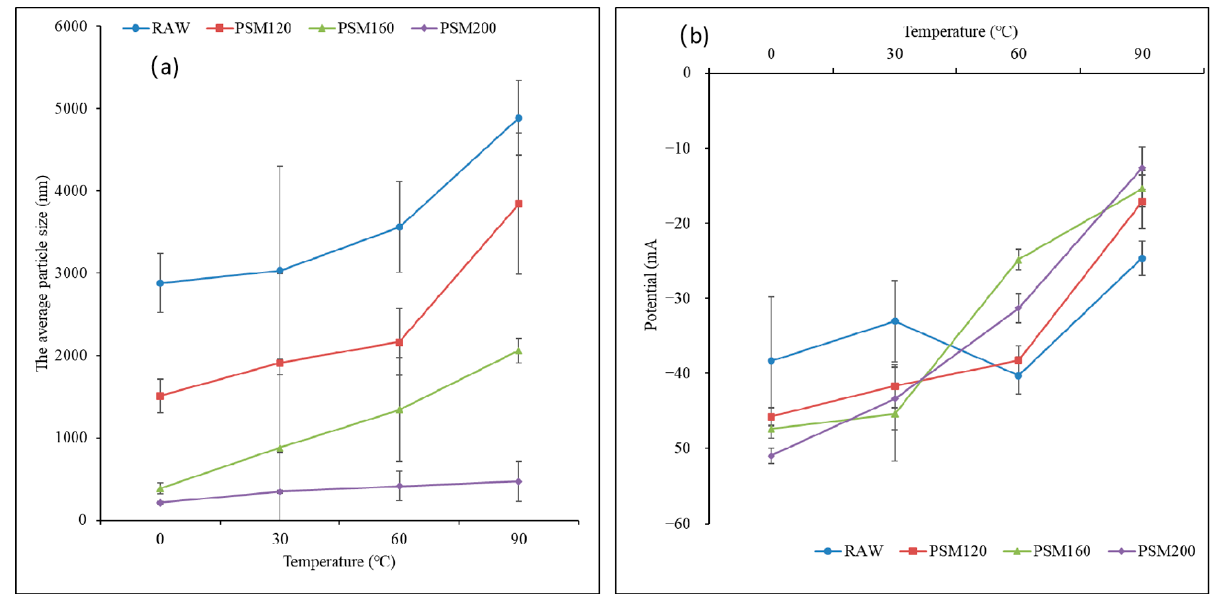
Figure 9. ( a ) Effect of heat treatment on average particle size of PSMs. ( b ) Effect of heat treatment on ζ -potential of PSMs. RAW: raw pumpkin seeds, PSM120: pumpkin seeds roasted at 120 °C, PSM160: pumpkin seeds roasted at 160 °C, and PSM200: pumpkin seeds roasted at 200 °C. Different lowercase letters represent the significant difference of ζ -potential of different pumpkin seed milks at the same salt concentration, and different uppercase letters represent the significant difference of ζ -potential of the same milk at different salt concentrations.